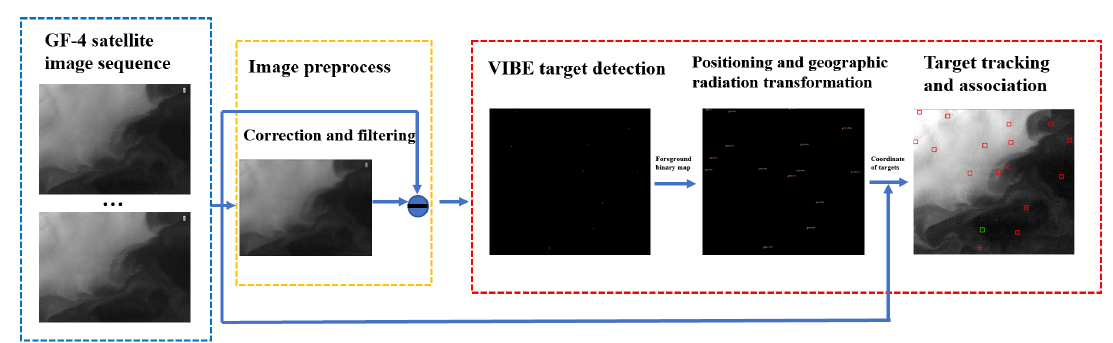
Figure 3. The overall process of detection and